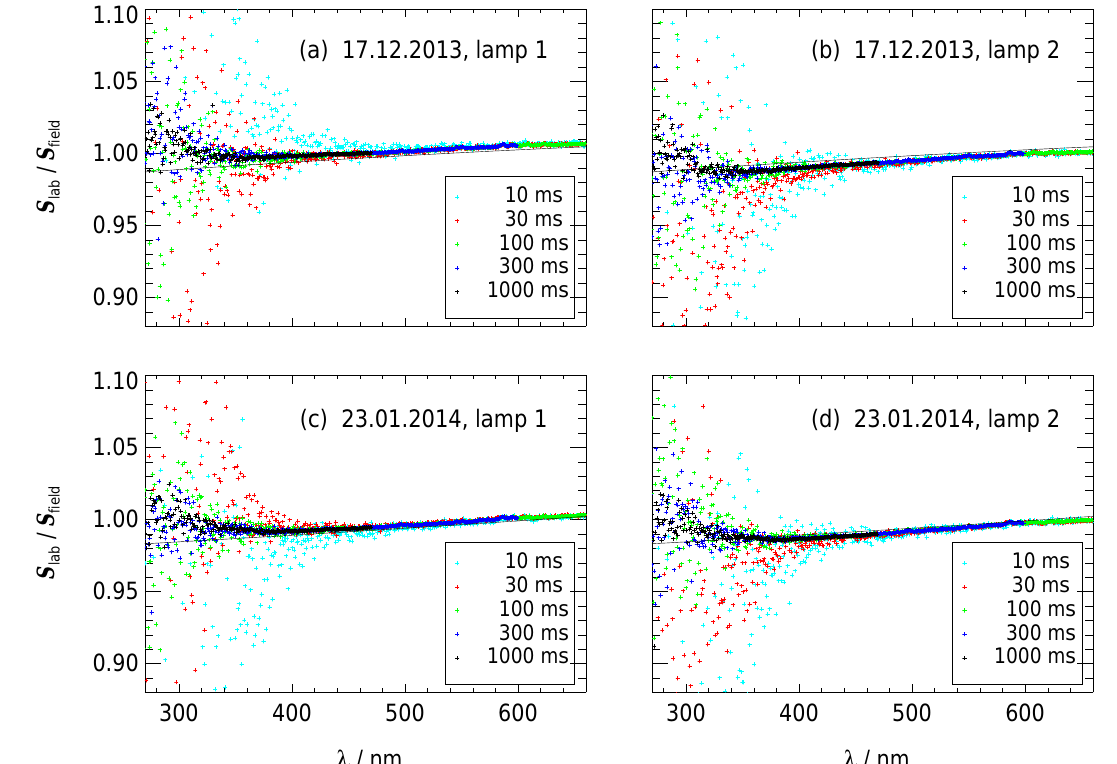
Figure 10. Ratios of dark-corrected signals of 45W traveling standard lamps obtained with instrument 62001 after a laboratory calibration on 3 September 2013 ( S lab ) and directly before and after a deployment on HALO ( S field ) in panels (a, b) and (c, d) , respectively. Two lamps were used each during laboratory and field measurements. Data points show individual measurements for different integration times; full lines show the finally applied scaling factors for each date (polynomial fits, mean of measurements with both lamps on a specific